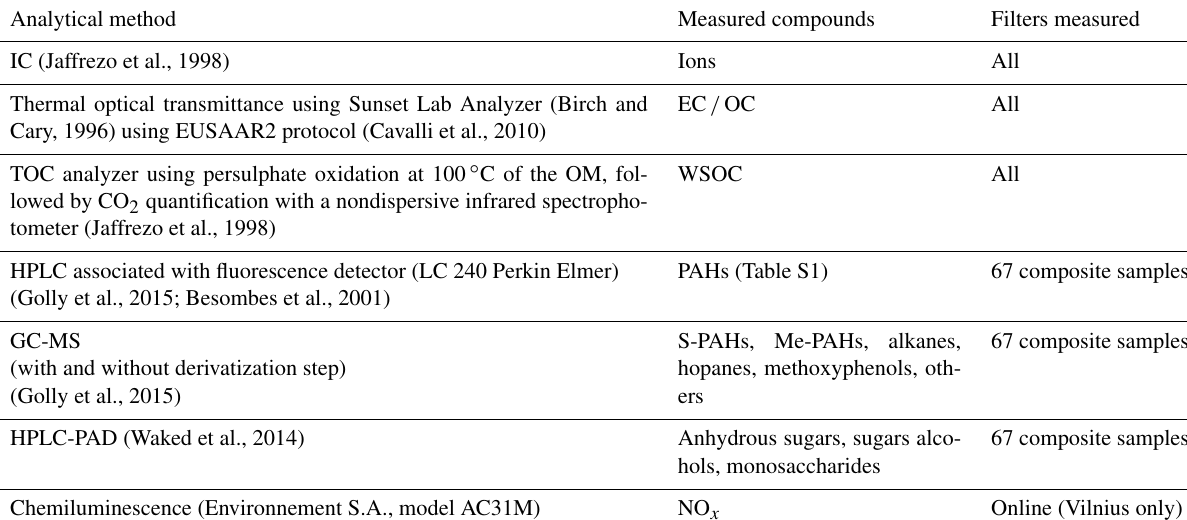
Table 1. Overview of supporting measurements. A complete list of measured compounds can be found in Table S1. Analytical method Measured compounds Filters measured IC (Jaffrezo et al., 1998) Ions